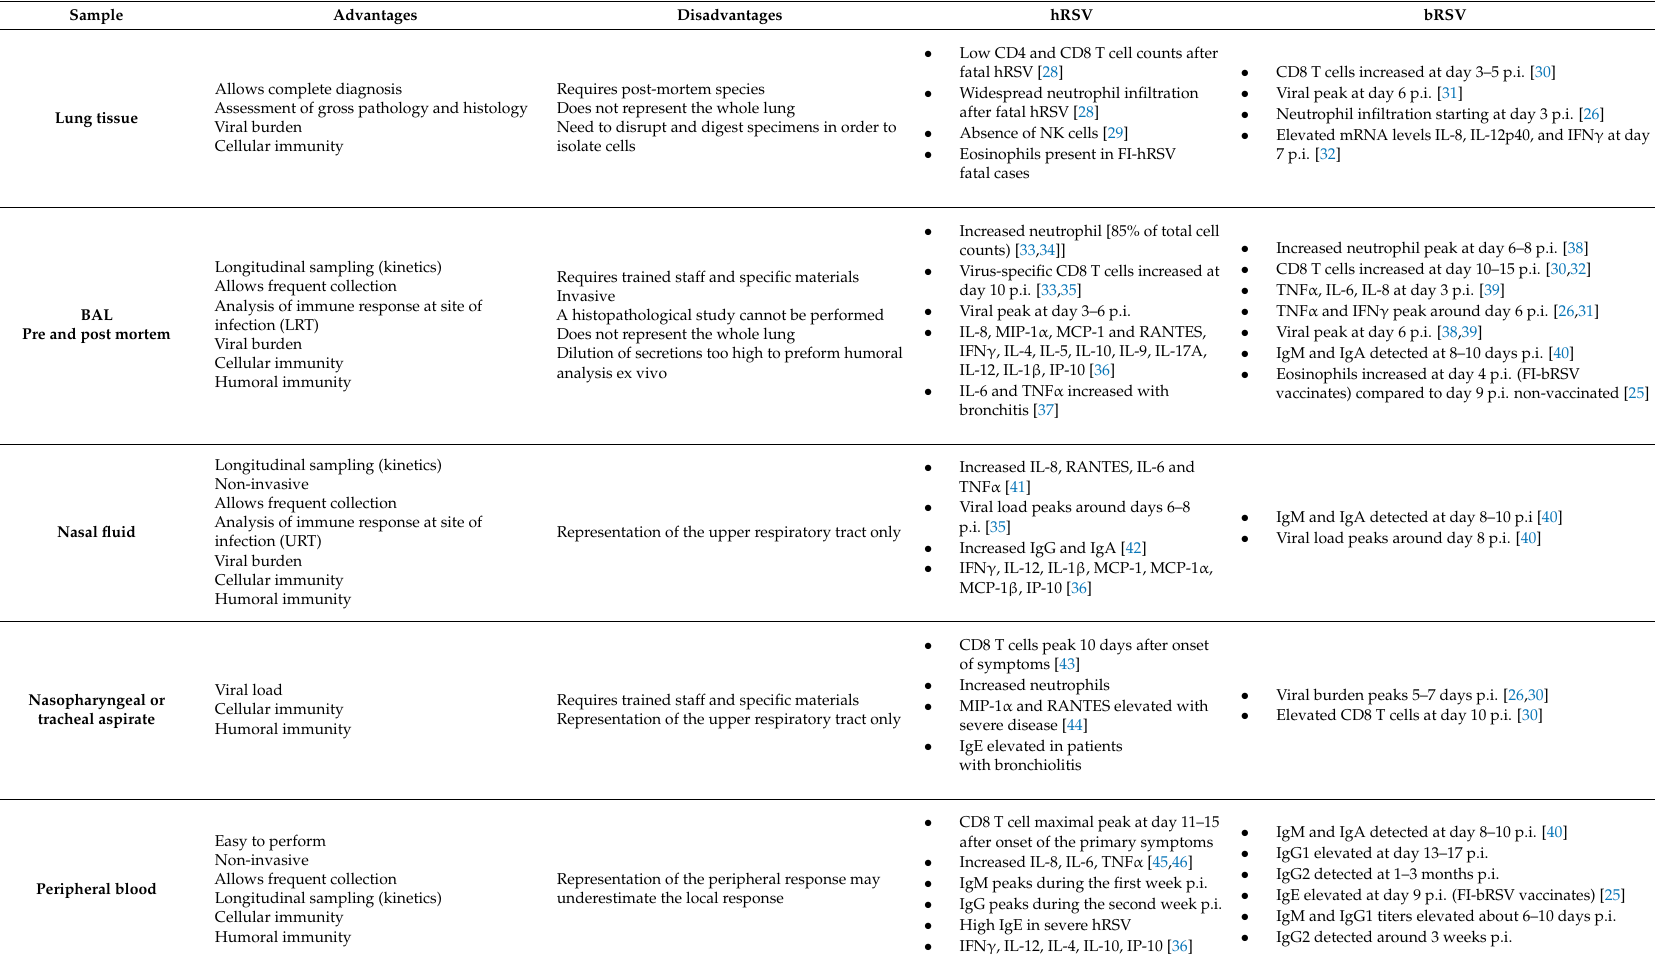
Table 1. Samples used to evaluate immune responses to natural and experimental infection in humans and